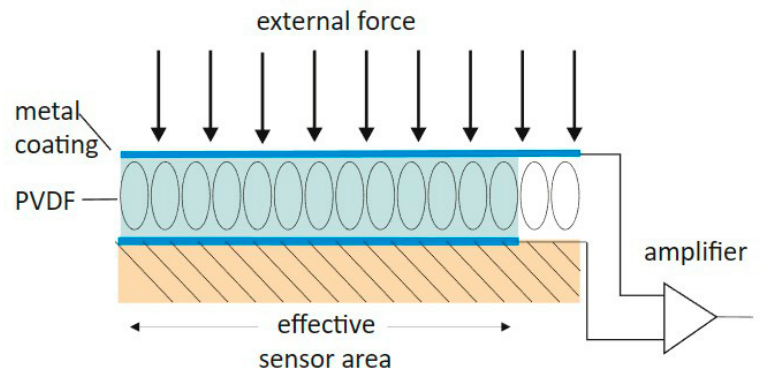
Figure 3. Geometric schematic of the dual PES/PCS sensor system. Described are the main compo- nents that track and relay the signals from an incoming force. PVDF = polyvinylidene fluoride.